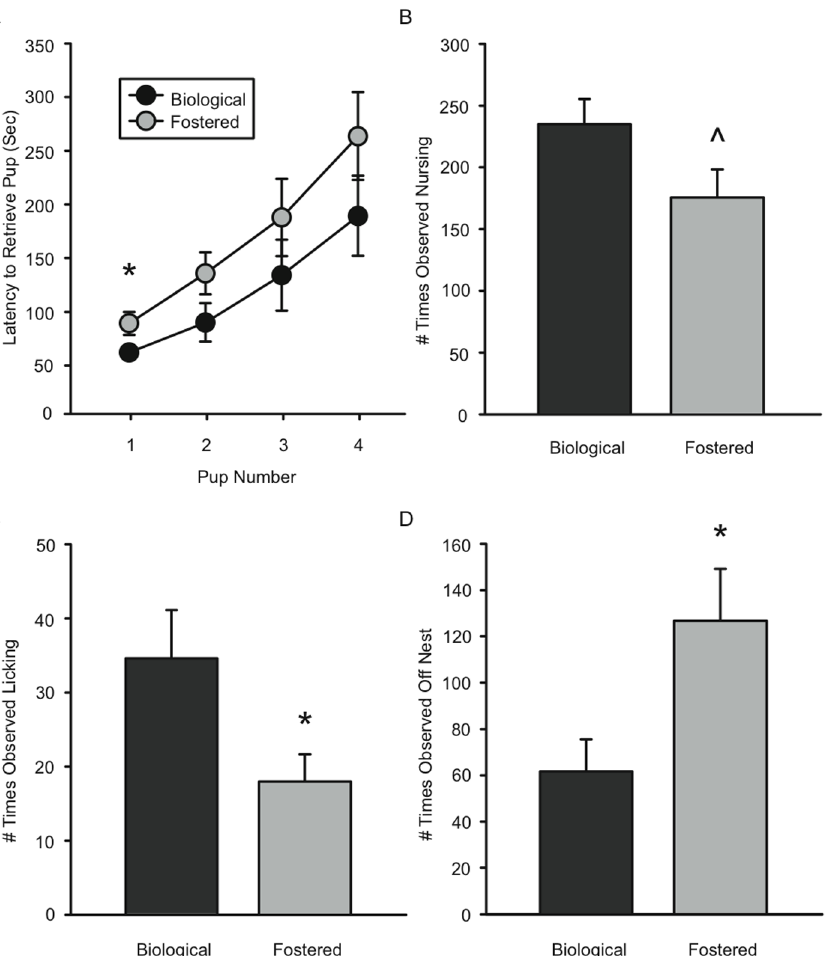
Figure 3. Foster pups change maternal behavior of B6 dams. (A) Mean ( + /– SEM) cumulative latencies to retrieve each of 4 pups to the nest. * Fostering significantly increased the latency to retrieve pups in the home-cage (p , 0.05). Specifically, foster dams (n=10) were significantly slower than biological dams (n=9) to retrieve the first pup (p , 0.04). (B–D) Mean ( + /– SEM) number of times dams were seen nursing (B), licking and grooming pups (C), and off the nest (D) * Foster dams licked and groomed their pups significantly less than biological dams (p , 0.04) and were off the nest more frequently than biological dams (p , 0.04). ˆ Foster dams exhibited a trend to nurse less frequently than biological dams (p , 0.08).